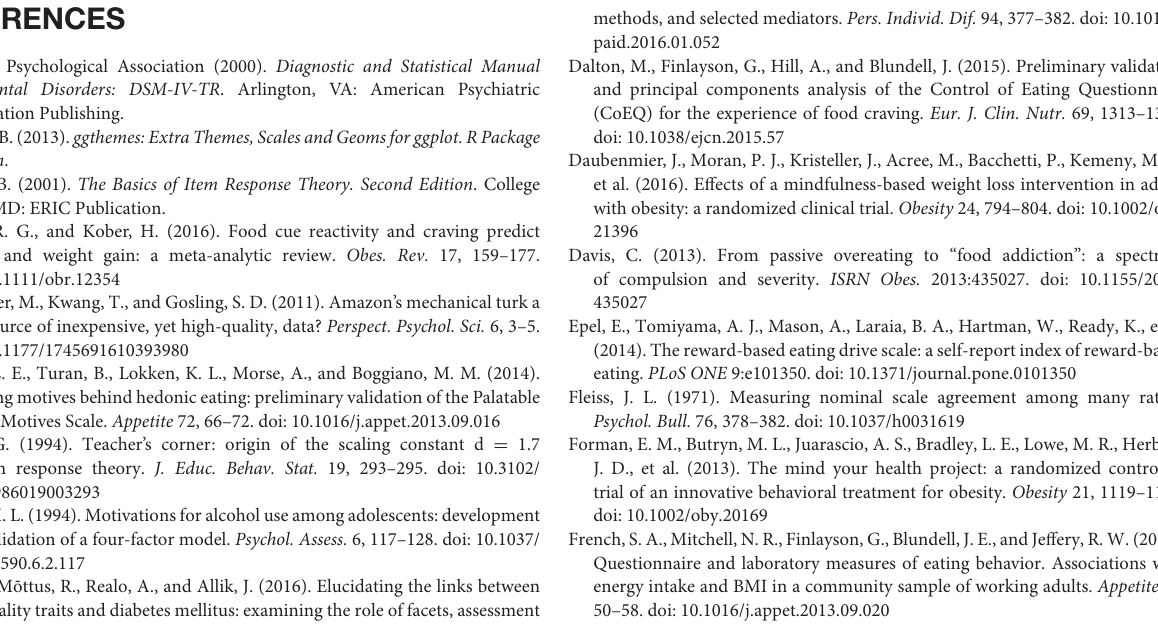
FIGURE S1 | Study 1: Person-item map and histogram depicting thresholds on the spectrum of reward-related eating (RRE) using all items with factor loadings greater than 0.45 ( n = 27 additional items, plus all RED-9 items). The histogram at top displays the locations of participants on the RRE construct. The top row of the person-item map at bottom depicts the locations of the gaps in coverage of the RRE construct left by the RED-9. The 27 items listed below “thresholds of RED items” are ordered by the average of their thresholds’ values, and colored by the respective scale from which they originate. Circles depict each threshold, i.e., location on the RRE construct where people are most likely to move from one response option to the next. Gray rectangles appear whenever the gap between two current RED item thresholds is wider than 0.29 units. FIGURE S2 | Study 2: Person-item map and histogram depicting thresholds on the spectrum of RRE using all items with factor loadings greater than 0.45 ( n = 77 additional items, plus all RED-9 items). See Supplementary Figure S1 note. FIGURE S3 | Study 3: Person-item map and histogram depicting thresholds on the spectrum of RRE using all items retained from Studies 1 and 2 ( n = 32 additional items, plus all RED-9 items). See Supplementary Figure S1 note. FIGURE S4 | Study 4: Person-item map and histogram depicting thresholds on the spectrum of RRE applying the item set identified in Study 4 ( n = 9 additional items, plus all RED-9 items) to the dataset from Study 3. See Supplementary Figure S1 note. Bars in darker gray indicate gaps in RRE coverage left by the RED-13. Bars in lighter gray indicate gaps in coverage left by